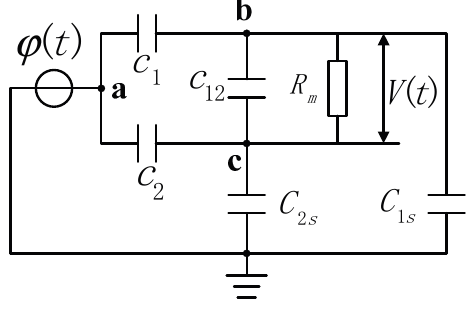
Figure 7. Equivalent circuit of the voltage sensor.